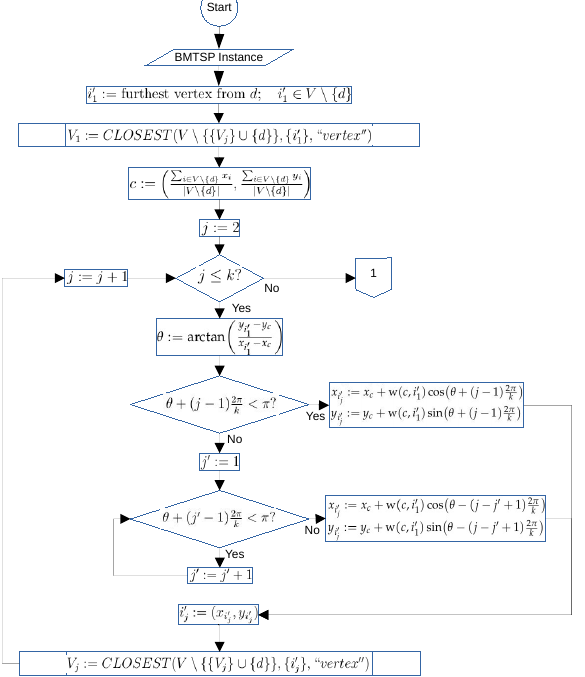
Figure 8. A basic flowchart of the partition algorithm to obtain the auxiliary points i (cid:48)